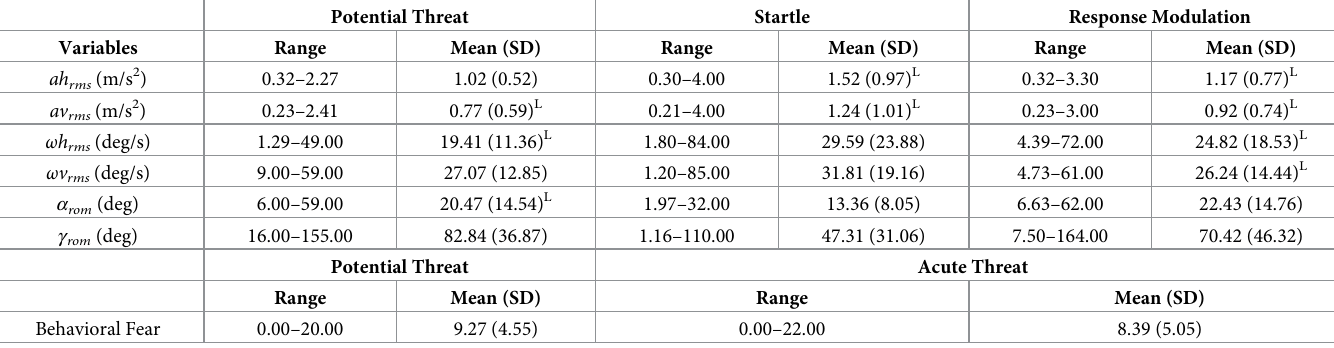
Table 2. Descriptive statistics of IMU-derived movement variables and behavioral fear codes during mood induction